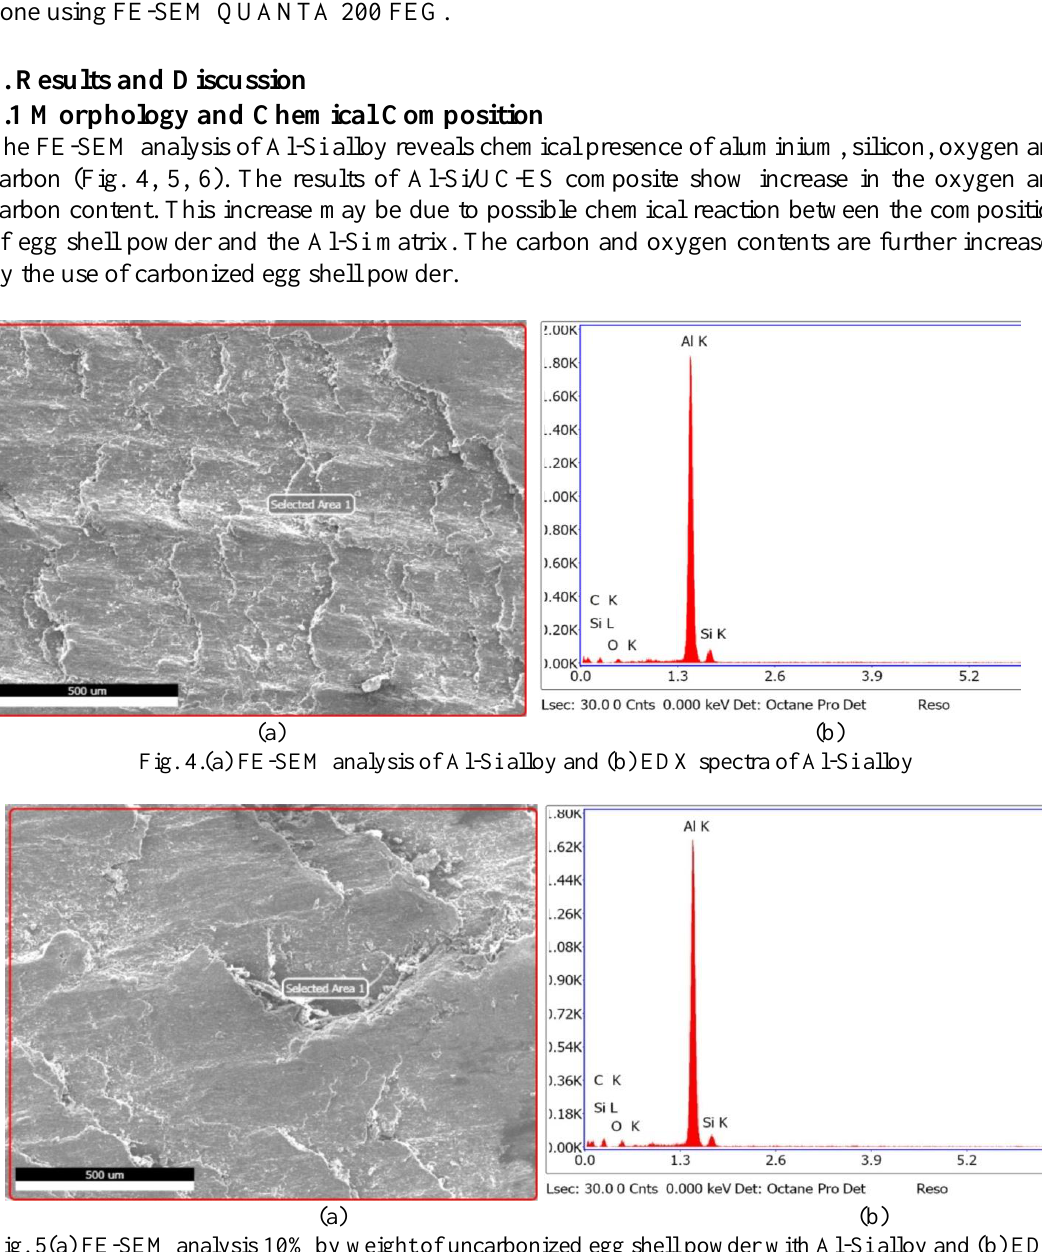
Fig. 5(a) FE-SEM analysis 10% by weight of uncarbonized egg shell powder with Al-Si alloy and (b) EDX spectra for